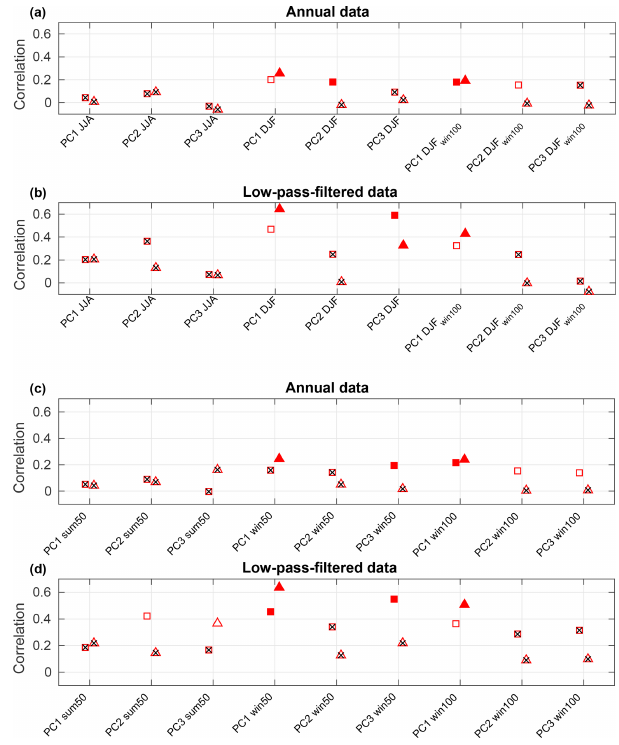
Figure 13. Correlation analysis for reconstructed PC1, PC2 and PC3 of SSTs using eight ice cores (triangles) and 19 ice cores (squares) correlated with PC1, PC2 and PC3 of COBE SSTs cover- ing 1851–1970. Open markers indicate significance of p < 0 . 1 and full markers indicate p < 0 . 05, while crossed-out markers indicate p > 0 .